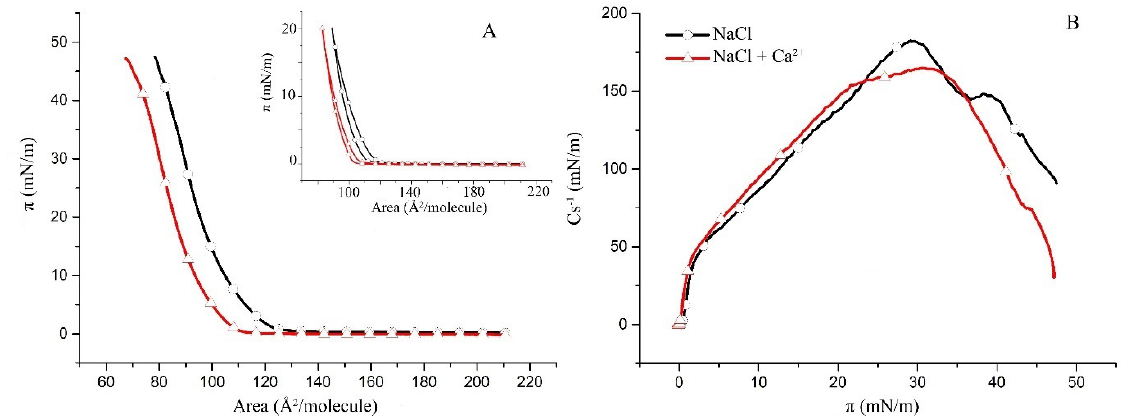
Figure 1. ( A ) Surface pressure/mean molecular area isotherms of the binary POPC/Chol (1:1) monolayers in a subphase of 150 mM NaCl (black) and in 150 mM NaCl supplemented with 0.5 µM CaCl 2 (red) at 35 ± 2 °C (inset: π /A hysteresis cycles of compression–decompression); ( B ) surface compressibility moduli C s − 1 derived from the isotherms in ( A ) as a function of surface pressure.